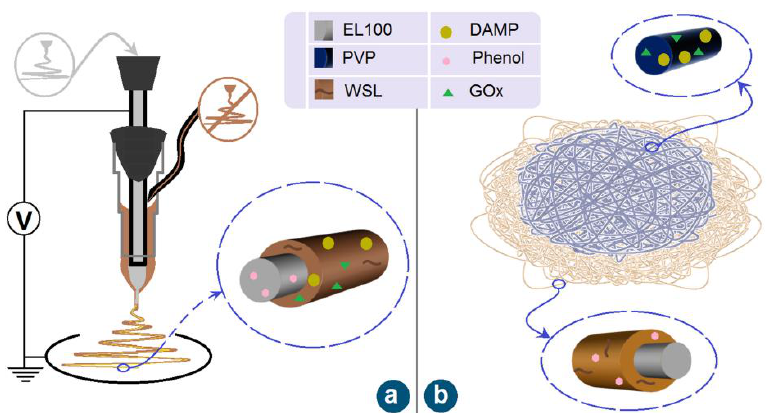
Figure 1. The modified coaxial electrospinning process ( a ) and the sequential collections of core–sheath and monolithic nanofibers ( b ).